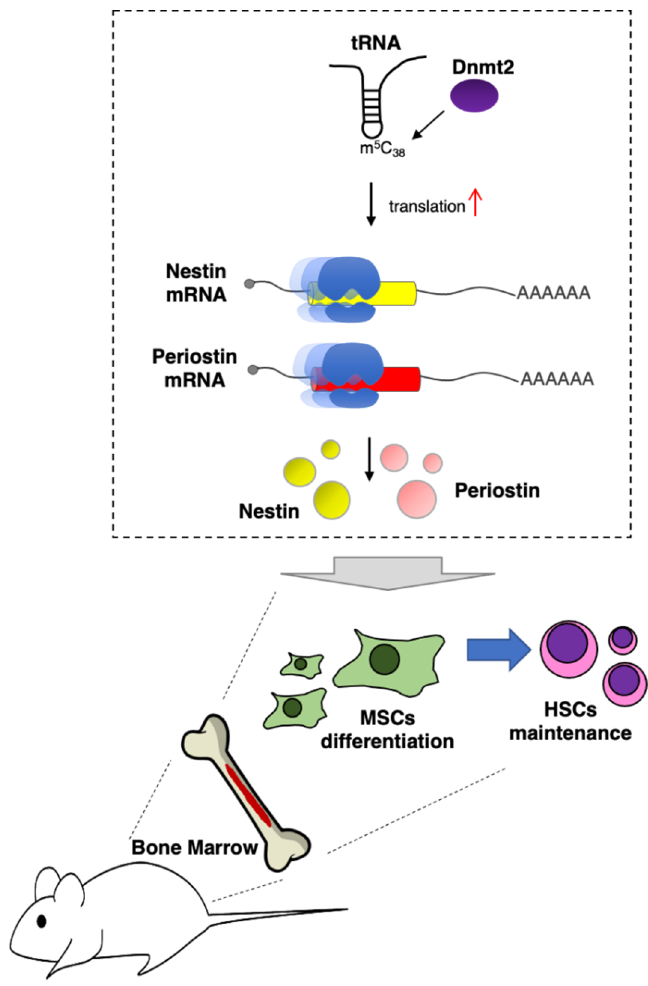
Figure 1. DNMT2 supports HSCs maintenance in vivo. DNMT2 installs m 5 C 38 in tRNA